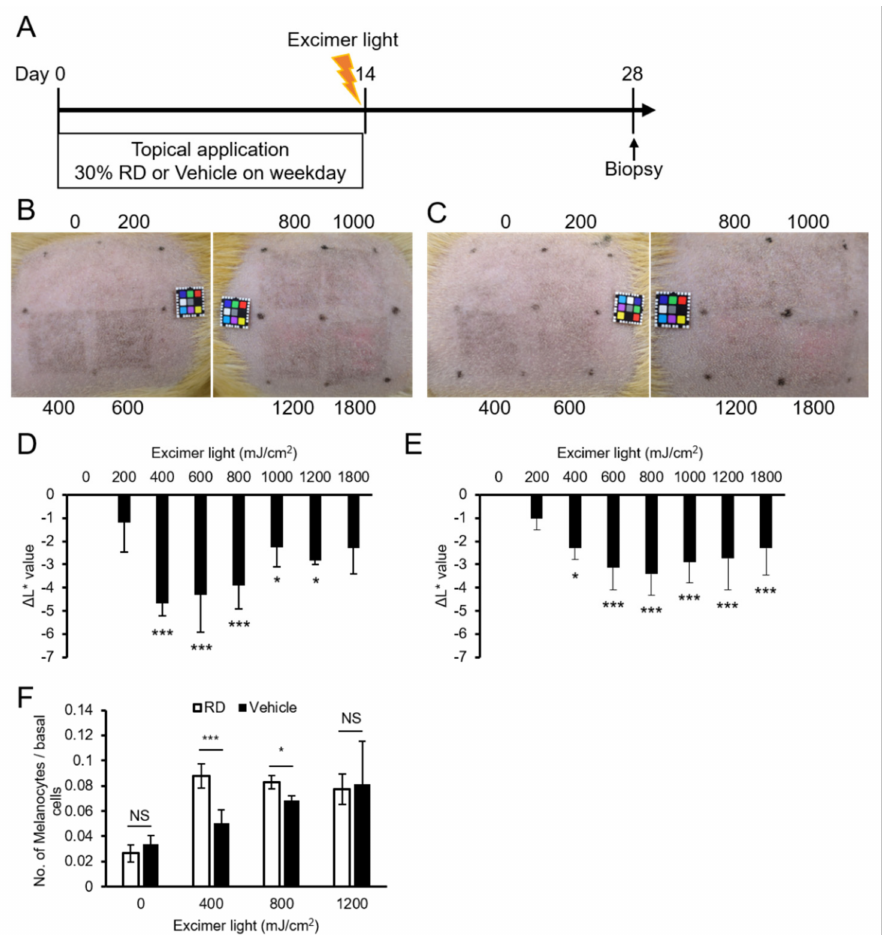
Figure 5. Monochromatic excimer light irradiation with a lower dose effectively induced skin pigmen- tation and melanocyte expansion in rhododendrol (RD)-treated guinea pigs. ( A ) Experimental design. ( B ) Representative examples of the skin of RD-treated guinea pigs on day 28. ( C ) Representative examples of the skin of the vehicle-applied guinea pigs on day 28. ( D ) ∆ L* values of the skin of the RD-treated guinea pigs on day 28. ( E ) ∆ L* values of the skin of the vehicle-treated guinea pigs on day 28. ( F ) Quantitation of epidermal melanocytes from the skin of three guinea pigs for each condition. Data are shown as the means ± SD, * p < 0.05; *** p < 0.01; Student’s t